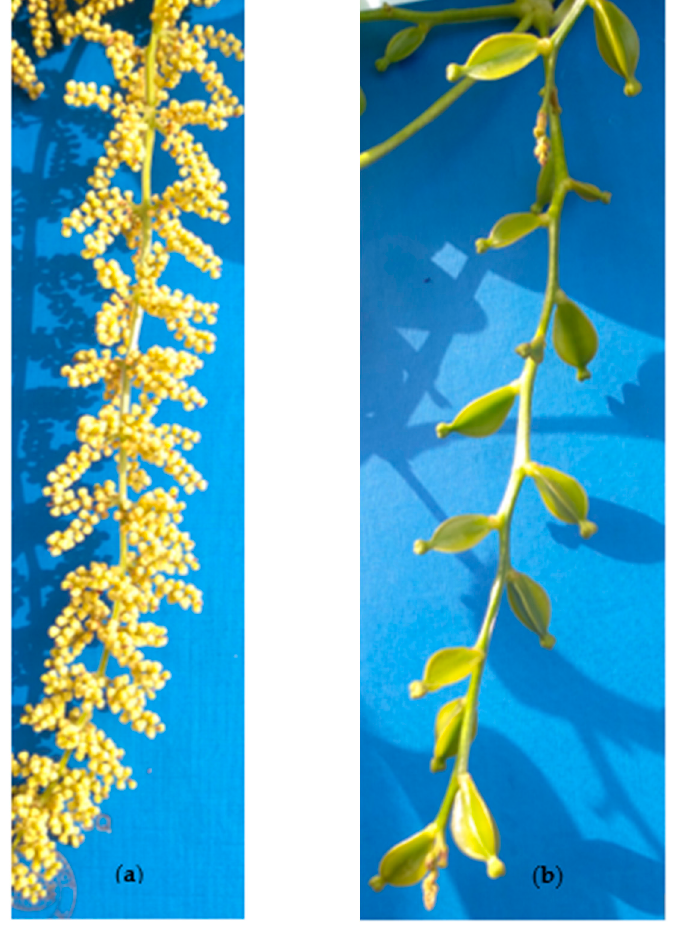
Figure 8. Morphological differences of D. alata flowers based on sex: ( a ) inflorescence with male flowers, ( b ) inflorescence with female flowers.